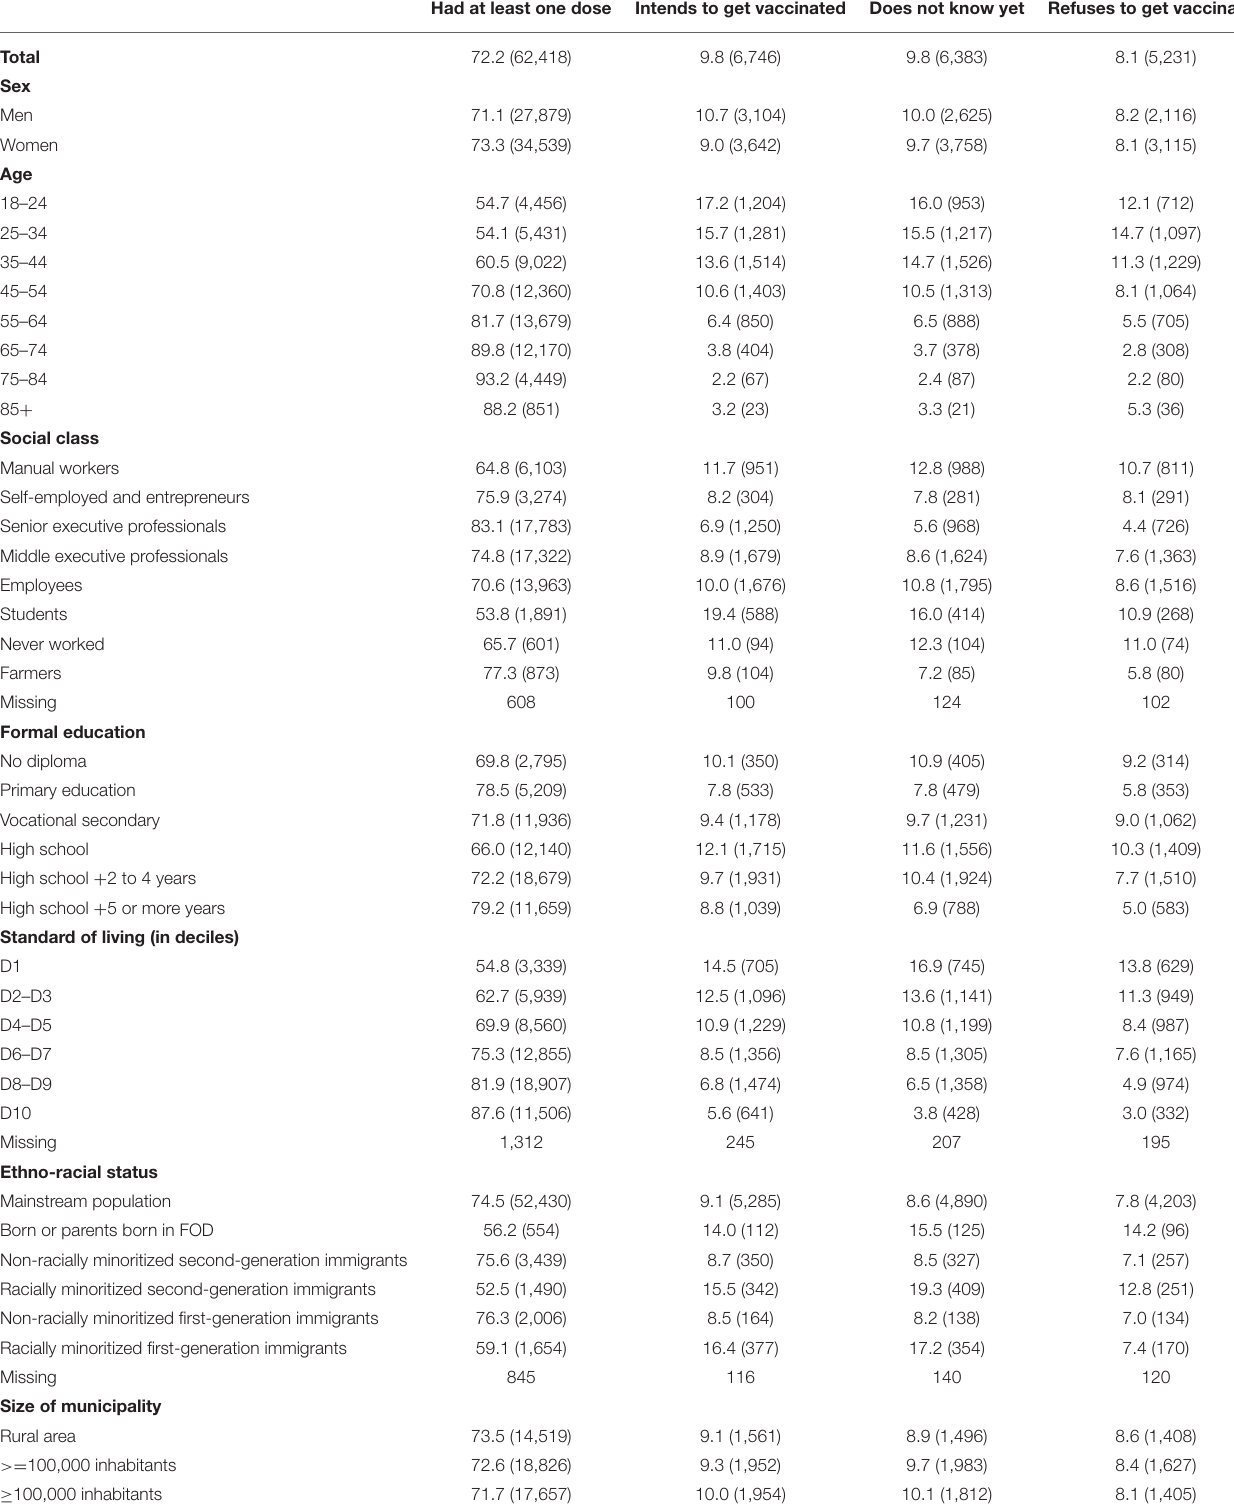
TABLE 1 | Distribution of the vaccinal status of people aged 18 years or over living in metropolitan France, by socio-demographic characteristics and trust variables. Had at least one dose Intends to get vaccinated Does not know yet Refuses to get